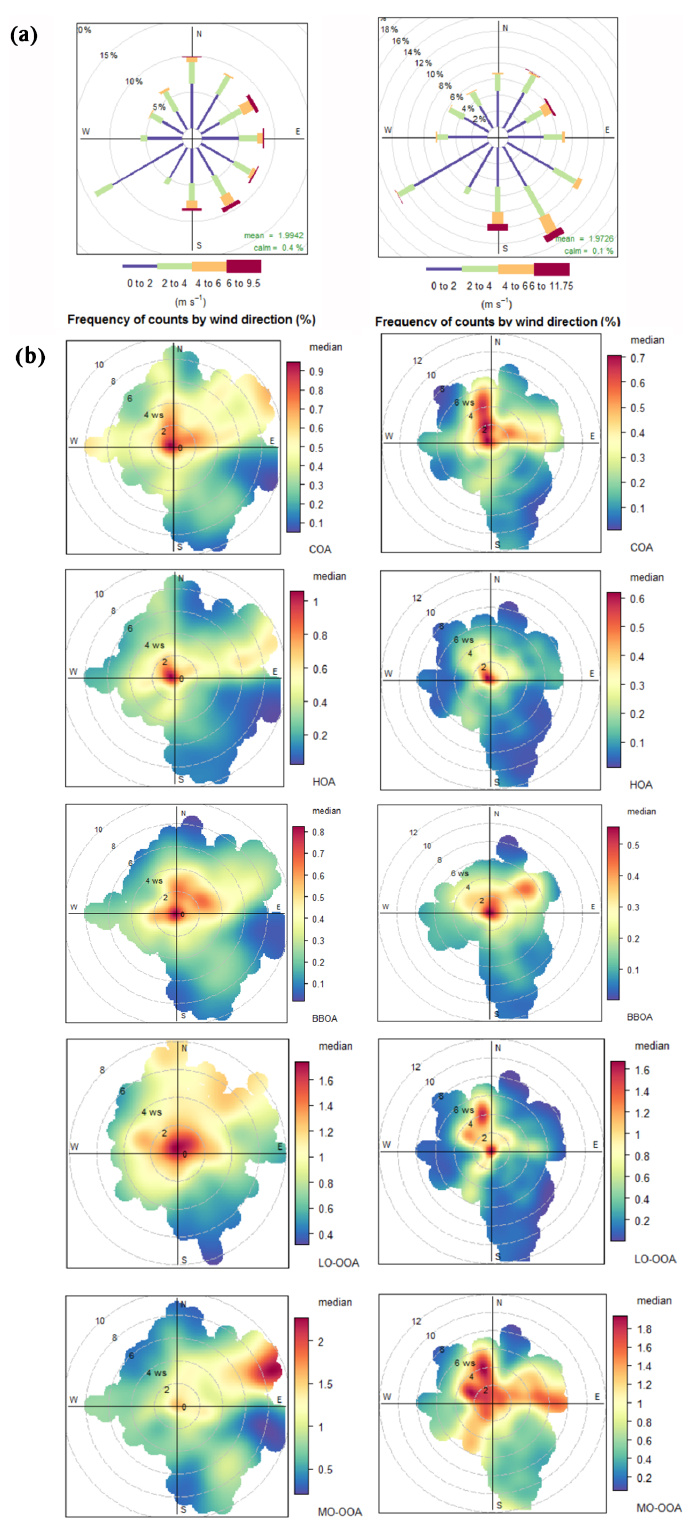
Figure 7. Wind dependence of OA factors. (a) Wind rose plots showing frequency of counts (in percentage) regarding wind direction and wind speed (ms − 1 ). (b) Polar plots colour-coded by median mass concentrations (µgm − 3 ) of OA factors listed below. In both cases, plots are arranged to the left for period A and to the right for period